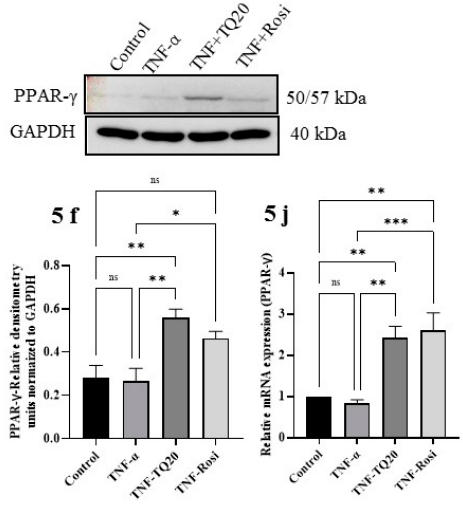
Figure 5. Effect of TQ on cell viability, proinflammatory chemokine mRNA, and PPAR- γ protein and mRNA expression in TNF- α challenged HT-29 human colon cancer cells. ( a , b ) A concentration-dependent cytotoxic effect of TQ was determined. ( c – e ) TQ treatment dose-dependently prevented the increase in CXCL-1, IL-8, chemokine, and COX-2 mRNA expression in TNF- α (1 ng/mL) challenged HT-29 cells. ( f,j ) TQ significantly increased PPAR- γ transcription factor protein, and mRNA expression in TNF- α challenged HT-29 cells. The density of the immunoblots was normalized to GAPDH. n = 4 separate experiments used for obtaining the data for protein and mRNA expression studies. The data expressed as means ± SEM. p ≤ 0.05 considered statistically significant. **** p < 0.0001, *** p < 0.001, ** p < 0.01, and * p < 0.05. (NS) not